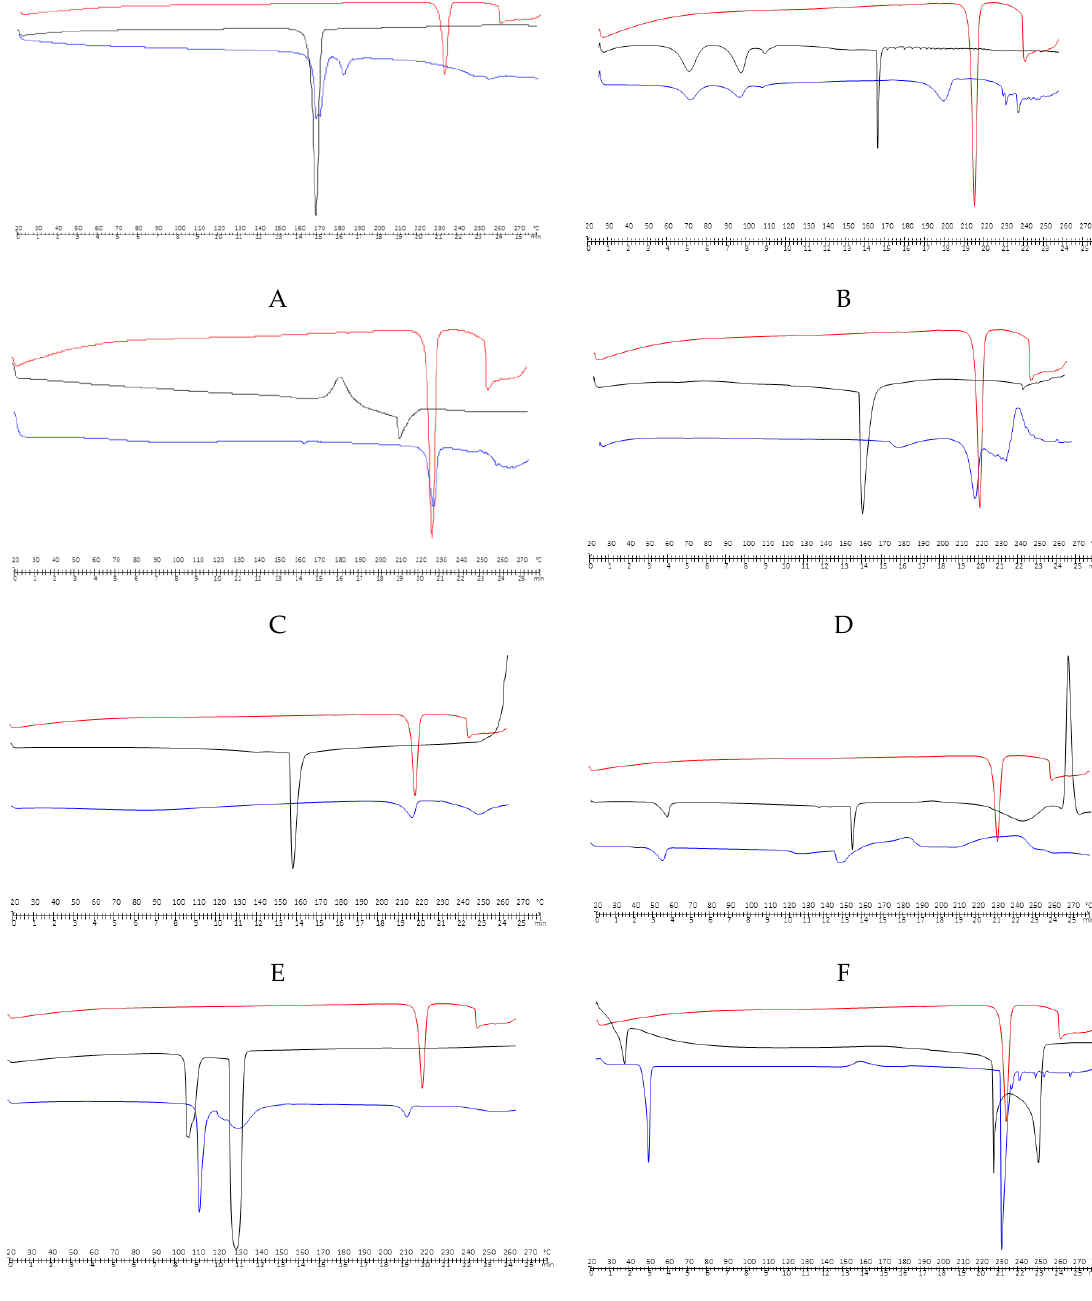
Figure 2. ( A ) Di ff erential scanning calorimetry (DSC) of loperamide HCl, mannitol and physical mixture; ( B ) DSC of loperamide HCl, magnesium stearate and physical mixture; ( C ) DSC of loperamide HCl, HPMC and physical mixture; ( D ) DSC of loperamide HCl, anise and physical mixture; ( E ) DSC of loperamide HCl, Explotab ® and physical mixture; ( F ) DSC of loperamide HCl, sodium cyclamate and physical mixture; ( G ) DSC of loperamideHCl, Emcompress ® and physical mixture; ( H ) DSC of loperamide HCl, menthol and physical mixture.